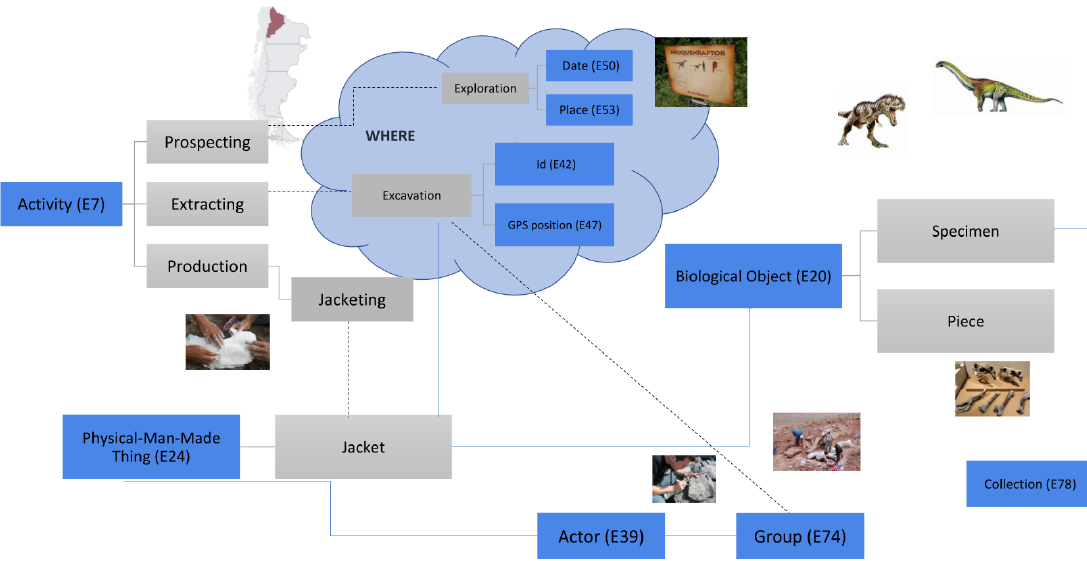
Figure 5. Part of the paleontological conceptual model mapped to entities of